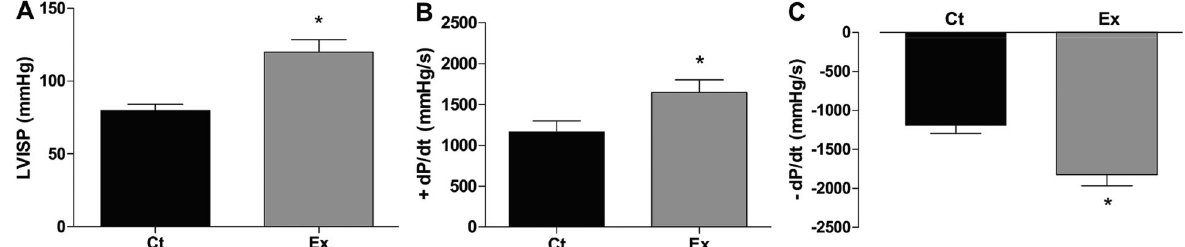
Figure 1. Contractility values from isolated heart. A , left ventricular isovolumetric systolic pressure (LVISP); B , positive fi rst time derivative ( + dP/dt), and C , negative fi rst time derivative ( (cid:1) dP/dt) from control (Ct, n=6) and exercised (Ex, n=6) spontaneously hypertensive rats (SHR) under control conditions in Langendorff apparatus. Results are reported as means ± SE. *P o 0.05, compared to Ct (Student ’ s t -test).